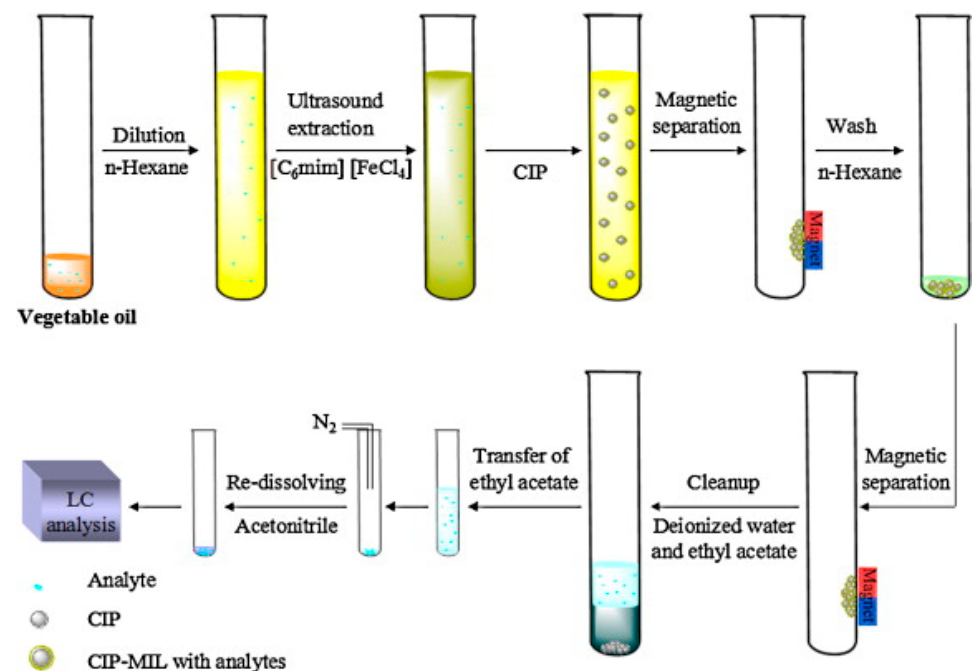
Figure 1. Schematic diagram of the DLLME extraction procedure of triazines from vegetable oils. Reproduced with permission from [22]. Copyright Elsevier, 2014.